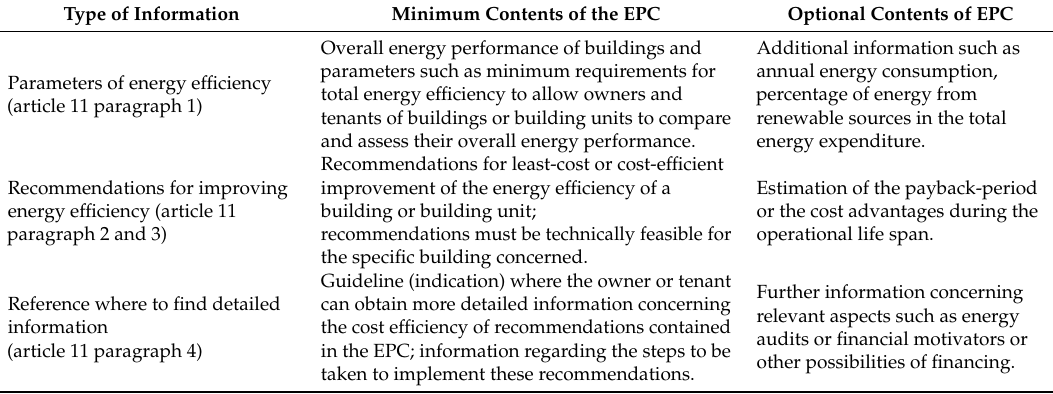
Table 1. Overview of minimum contents and optional contents of the Energy Performance Certificate